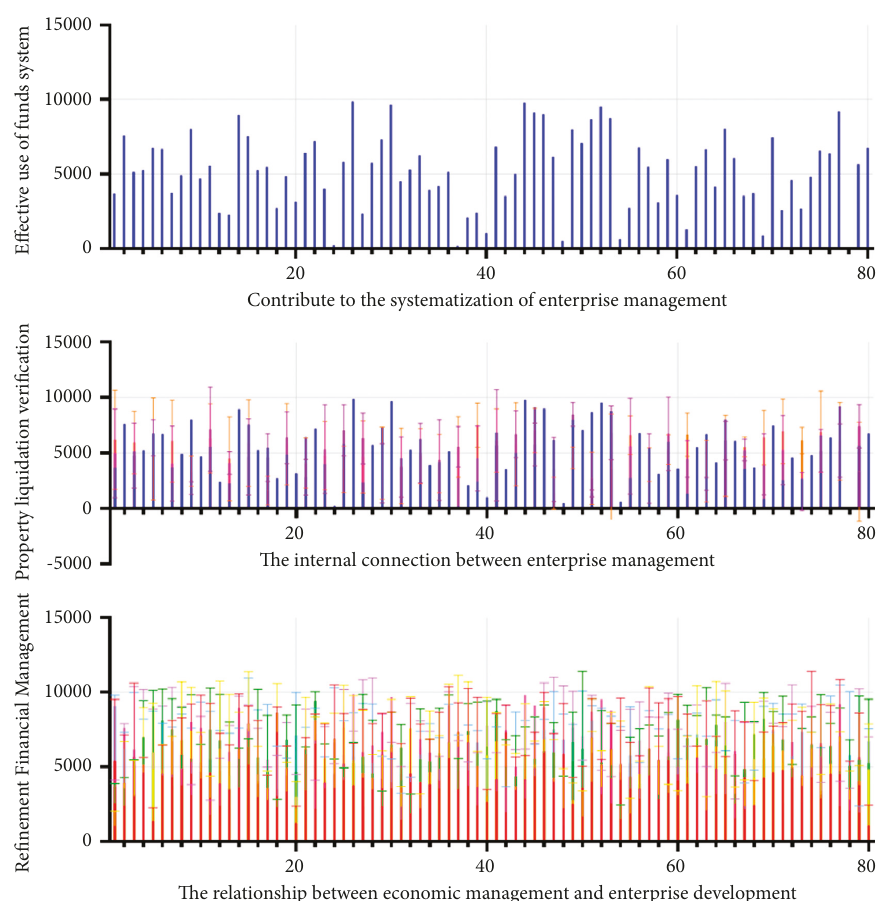
Figure 8: The relationship between economic management and enterprise